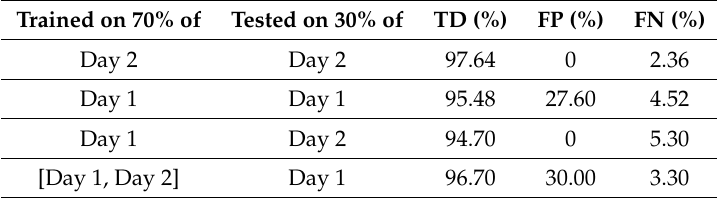
Table 3. Performance of the feature classification based method where the training and test sets are also